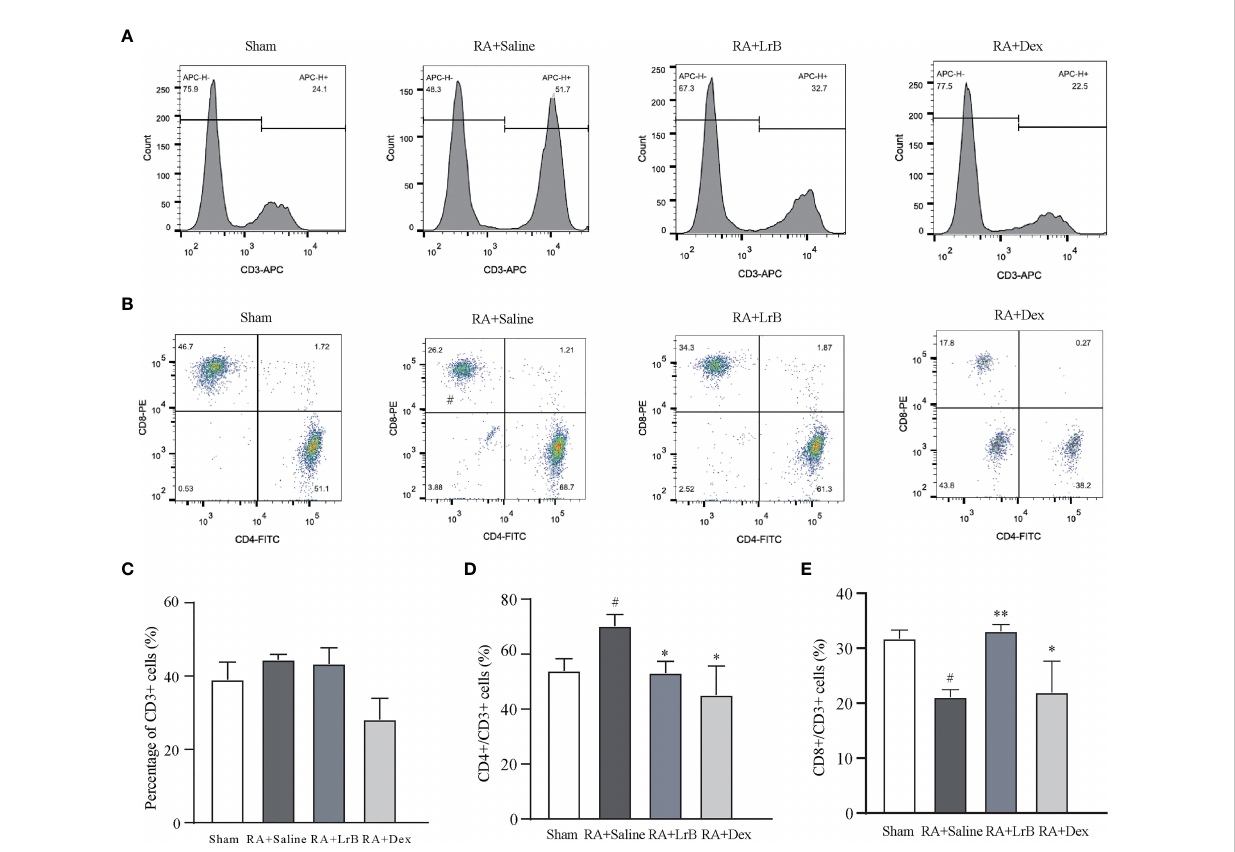
FIGURE 3 LrB changed the ratio of PBMCs in CIA rats. (A) Staining histogram of CD3+ T-cell subtype in peripheral blood mononuclear cells (PBMCs) of Sham and CIA rats with different treatments. (B) Scatter diagram of CD4+ and CD8+ T-cell subtypes in CD3+ T cells of CIA rats. (C) The proportion of CD3 + T cells in PBMCs of rats in each group. (D) The proportion of CD4+ T-cell subtype in CD3+ T cells. (E) The proportion of CD8+ T-cell subtype in CD3+ T cells. (Results are expressed as the mean ± SEM, and tested with One Way ANOVA. # P ≤ 0.05, compared to the Sham group; * P ≤ 0.05, ** P ≤ 0.01, compared to the RA+Saline